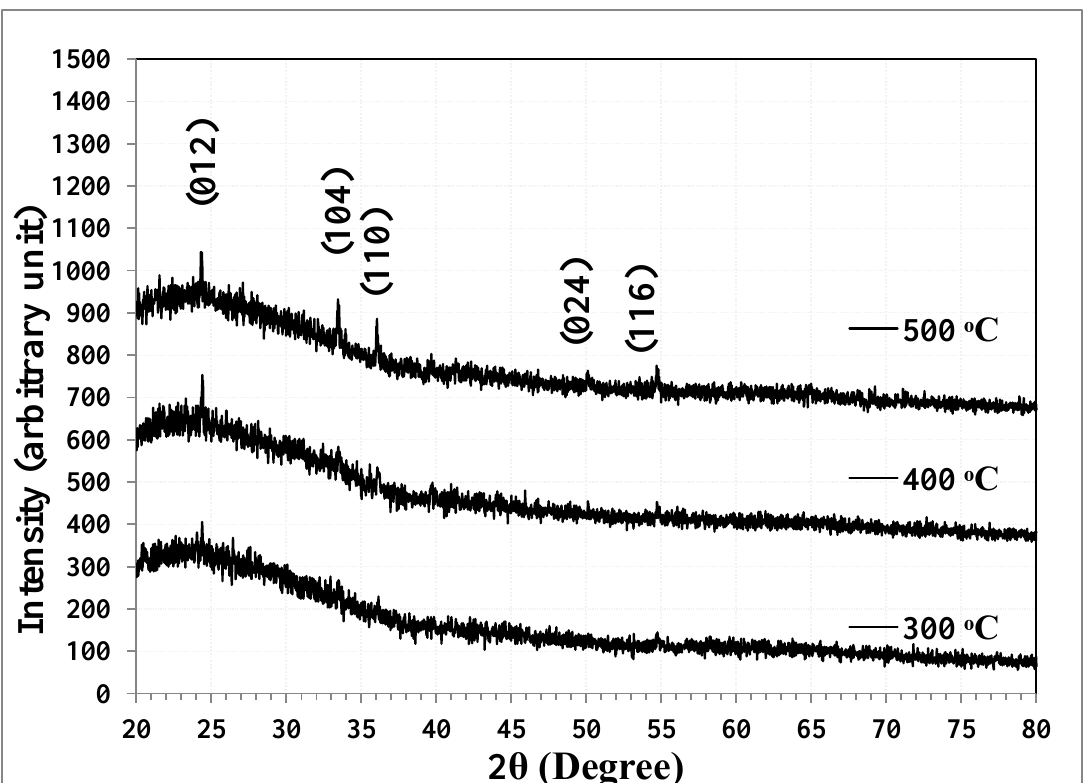
Fig. 2: X-ray diffraction of Cr